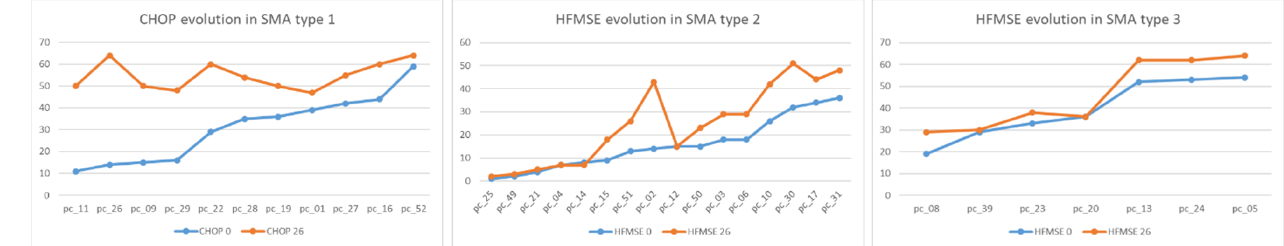
Figure 2. CHOP and HFMSE evolution at T0 and T26 for each type of